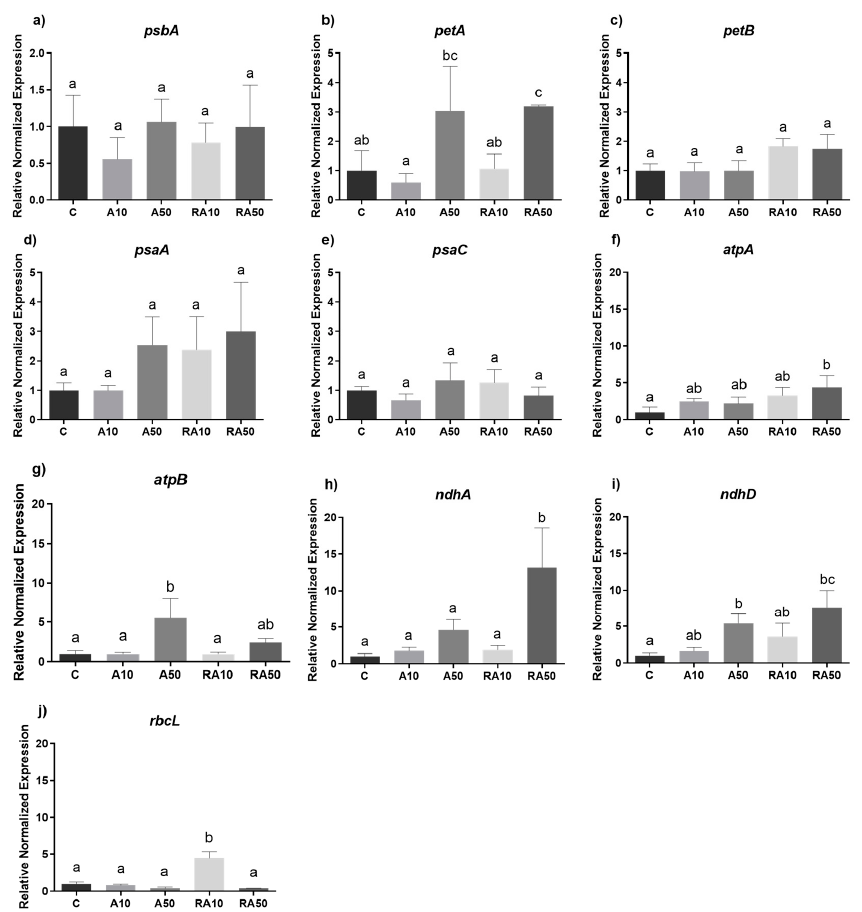
Figure 3. Effects of A and RA treatments on the expression of genes: ( a ) psbA , ( b ) petA , ( c ) petB , ( d ) atpA , ( e ) atpB , ( f ) psaA , ( g ) psaC , ( h ) ndhA , ( i ) ndhD , and ( j ) rbcL . Different letters mean significantly different values ( p <